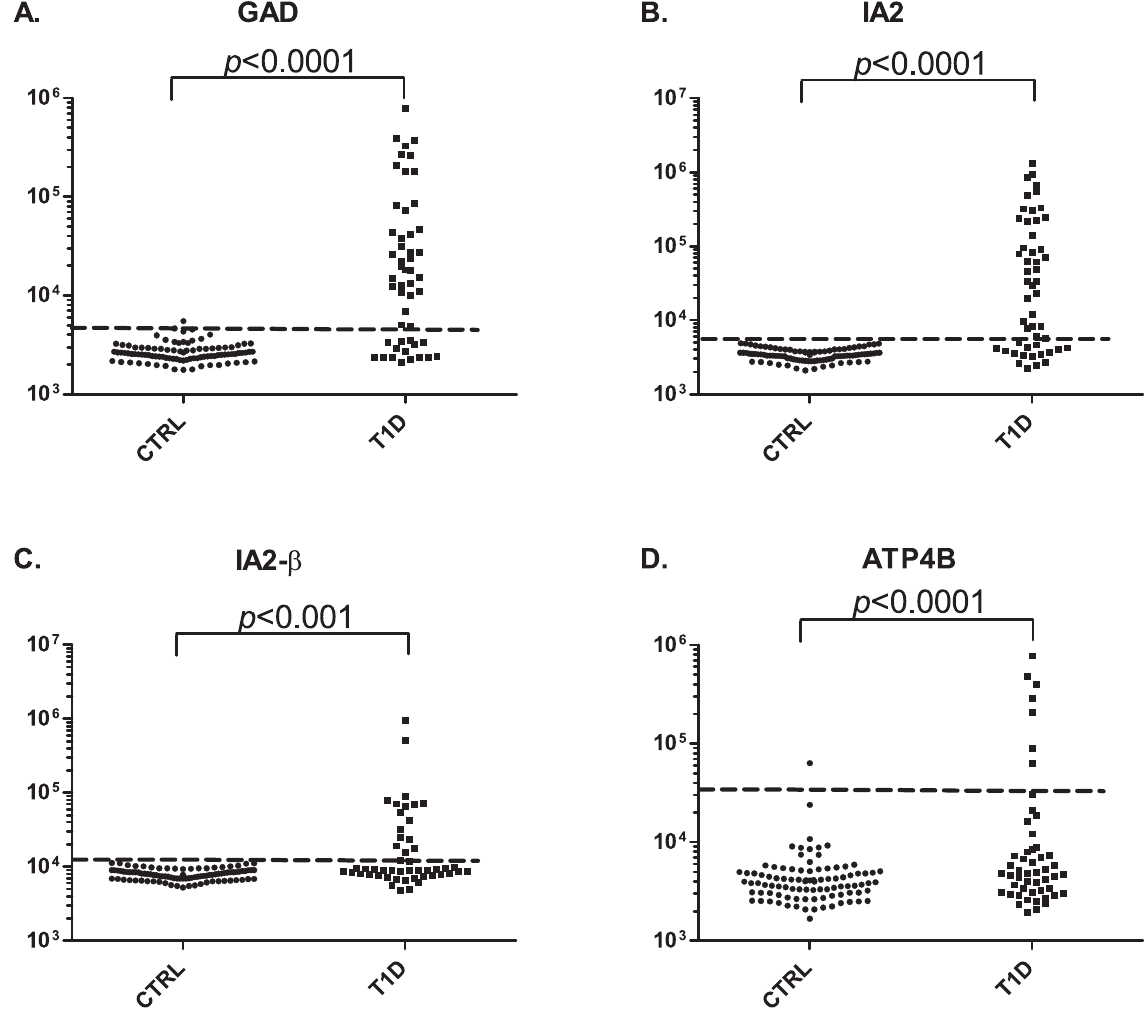
Figure 1. Autoantibodies in T1D and control subjects from DASP 2009. The mean antibody titer and 95% confidence interval for ( A ) GAD65 ( B ) IA2, ( C ) IA2- b , and ( D ) ATP4B titers in the 89 controls and 50 T1D subjects were plotted on the Y-axis using a log 10 scale. Each symbol represents a sample from one individual. The dashed line represents the cut-off level for determining seropositivity and is derived from the mean plus 3 standard deviations of the antibody titer of the controls. P values for the different groups were calculated using the Mann Whitney U test. (Figure 3). The islet only group (40%; 20/50) contained subjects who had autoantibodies only to islet cell autoantigens, while the second group (50%; 25/50) contained subjects who had autoan- tibodies against at least one non-islet target. A few diabetic subjects (10%; 5/50) showed no statistically significant autoantibodies above the control cut-offs to any of the antigens tested. Analysis of the two major groups showed that the individual T1D autoanti-